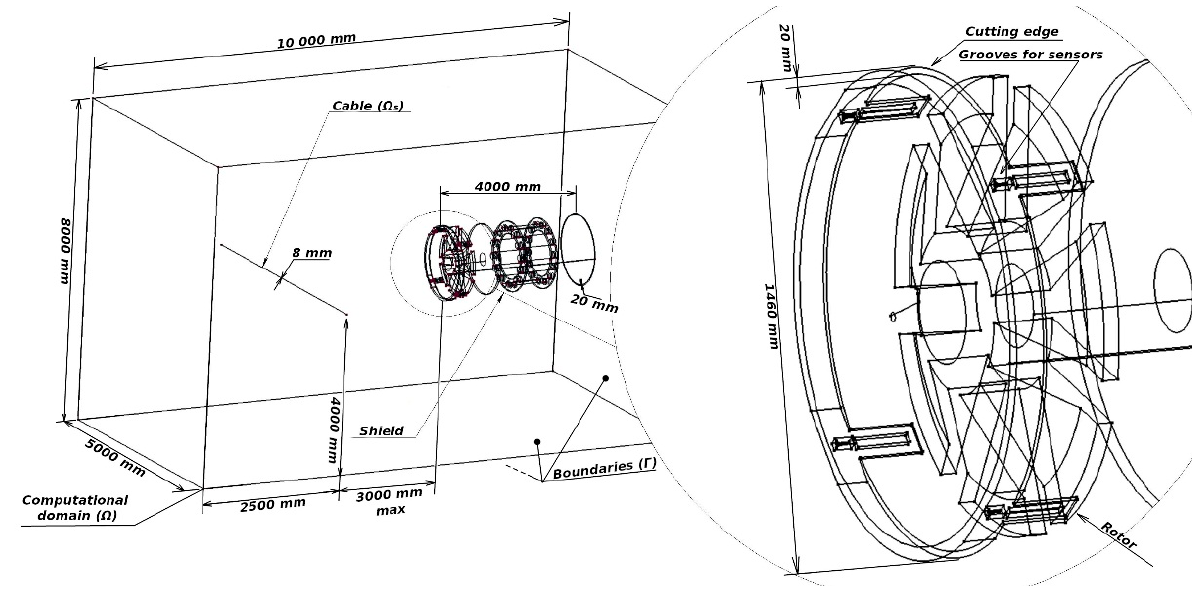
Figure 1. Geometrical model of the computational domain.